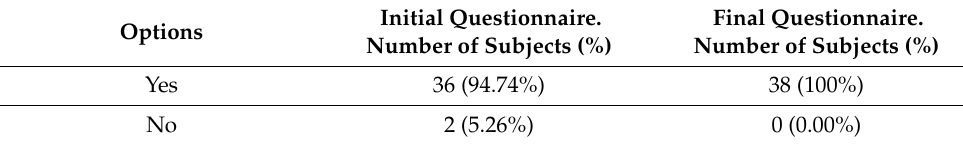
Table 5. Item 3: Willingness to use this type of application in other subjects. Initial Questionnaire. Final Questionnaire. Options